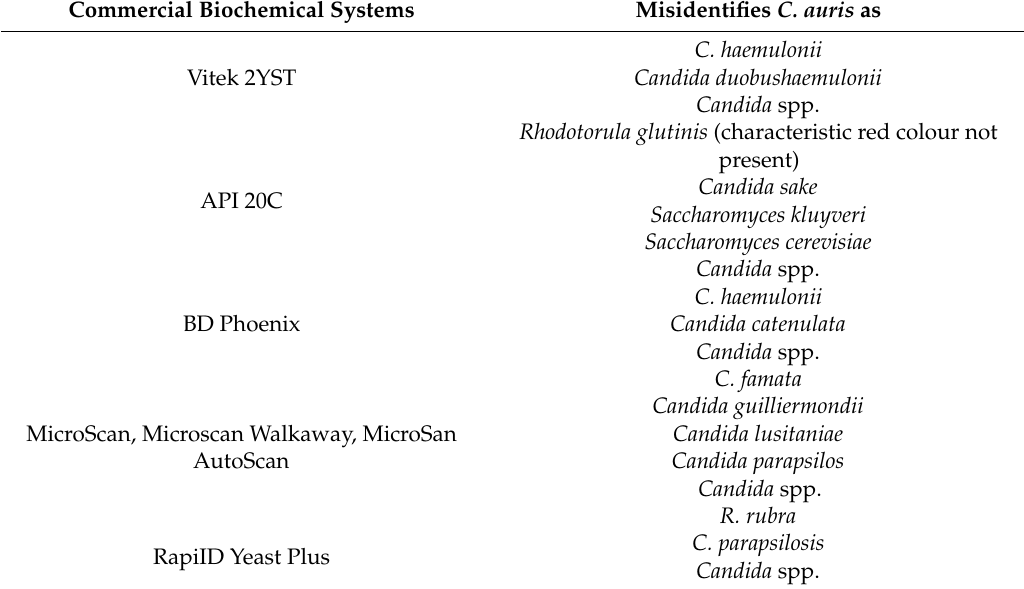
Table 1. Reported errors related to the identification of C. auris by commercially available biochemical tests.